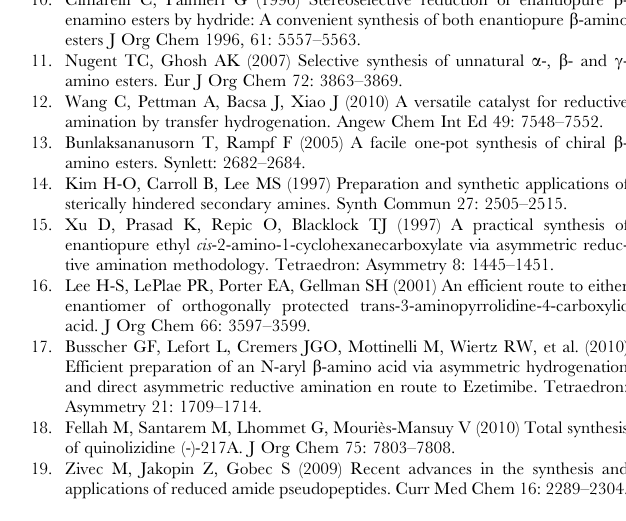
Figure S1 Chiral HPLC chromatograms for 1 and 3a. (PDF) Figure S2 Chiral HPLC chromatograms for 4a and 6a. (PDF) Figure S3 1 H NMR spectra for monitoring the interme- diate formation. (PDF) Figure S4 1 H NMR spectra of deuterated diamino esters 3a–3c. (PDF) Figures S5 1 H NMR spectra of deuterated diamino esters 4a–4b. (PDF) Figure S6 X-Ray packing of compound 7a. (PDF) Figure S7 X-Ray packing of compound 7b. (PDF) Figure S8 NMR Spectra for new compounds 2–8 (PDF) Table S1 Direct reductive amination trials. Table S2 Indirect reductive amination